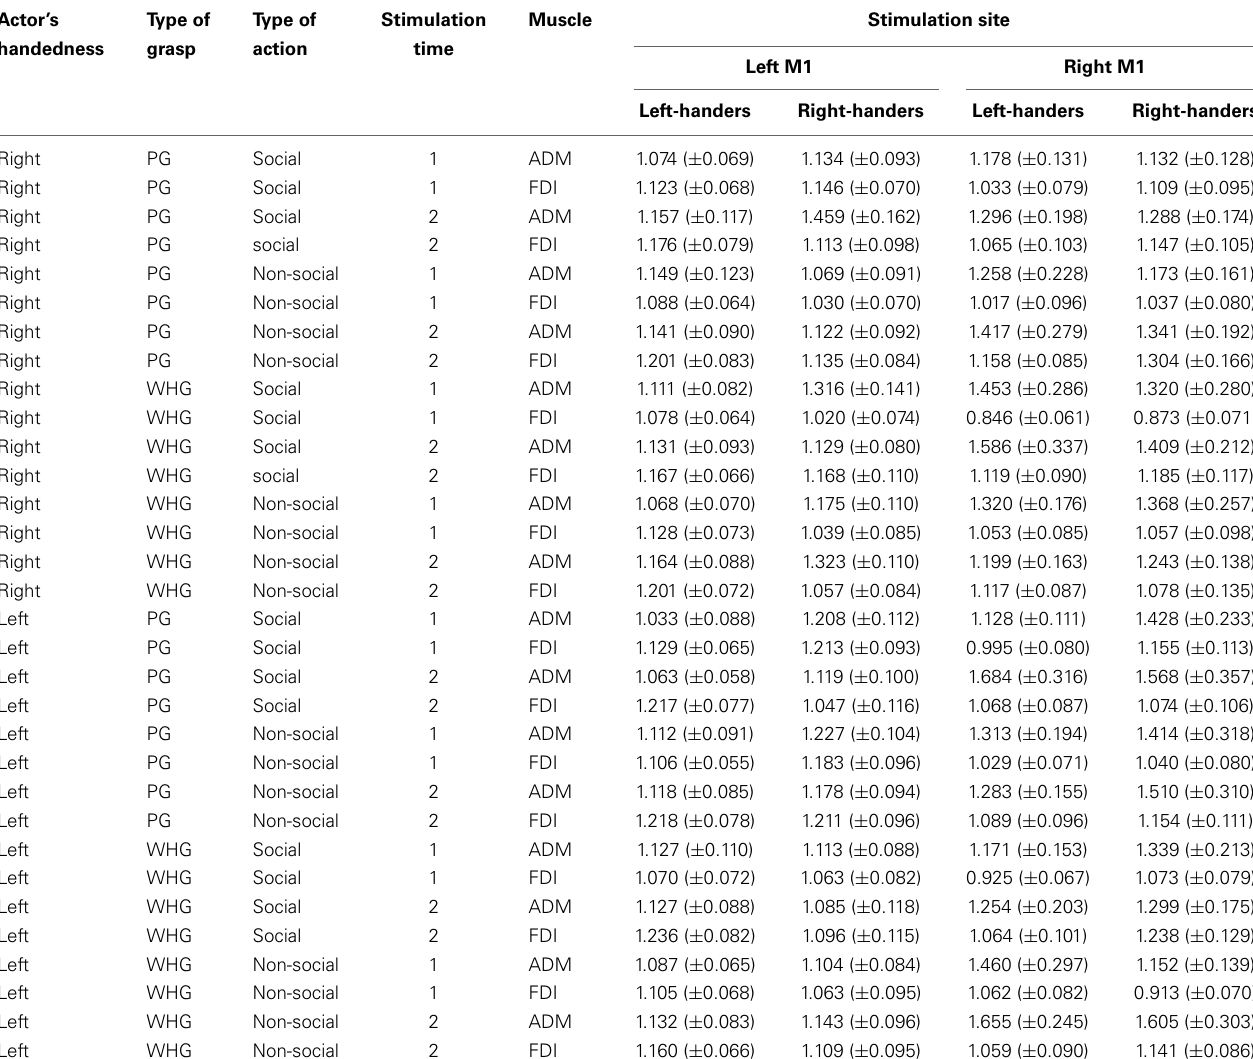
Table 1 | Normalized mean ( ± s.e.m.) peak to peak amplitude of MEPs recorded from the ADM and the FDI muscles of both groups during the two stimulation blocks for each type of observed actor, observed grasp and type of action at each stimulation time